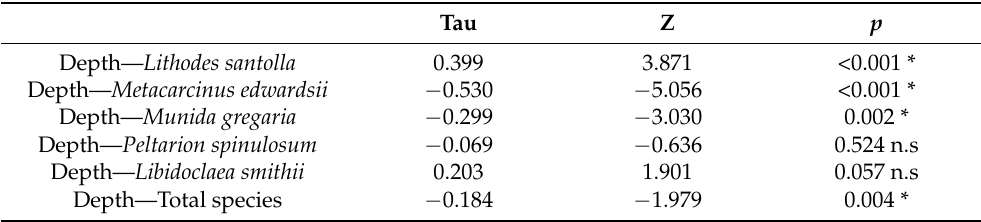
Table 3. Results of Kendall correlation analysis for decapod species reported and total decapod species reported and depth (“ p ” values lower than 0.05 and asterisks “*” denote significant correla- tions, n.s = non significant).